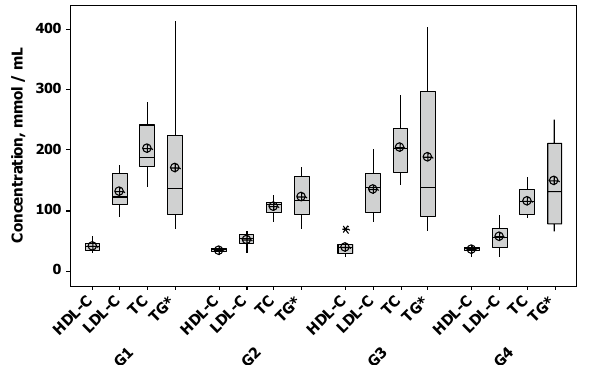
Figure 1. Evaluation of clinical results for the infarcted patients under investigation. G1: Patients randomized to the rosuvastatin group at the first day of myocardial infarction (D1); G2: Patients treated by rosuvastatin after 30 days (D30); G3: Patients randomized to the simvastatin + ezetimibe group at the first day of myocardial infarction (D1); G4: Patients treated by simvastatin plus ezetimibe after 30 days (D30). Total cholesterol (TC), low density lipoprotein—cholesterol (LDL-C), high density lipoprotein—cholesterol (HDL-C) and triglycerides (TG*). Figure was created in Minitab 17.0 (Minitab Statistical Software; URL: https:// www. minit ab. com/ pt- br/)) and Microsoft PowerPoint 2013 (URL: https:// www. micro soft. com/ pt- br/ micro soft- power point-